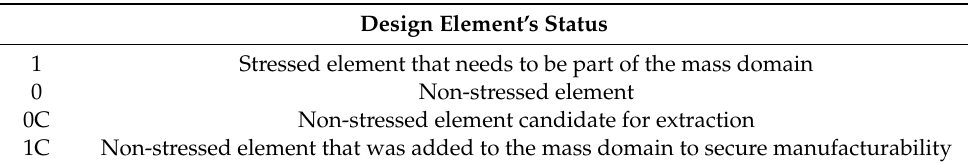
Table 4. Definition of voxels’ status.